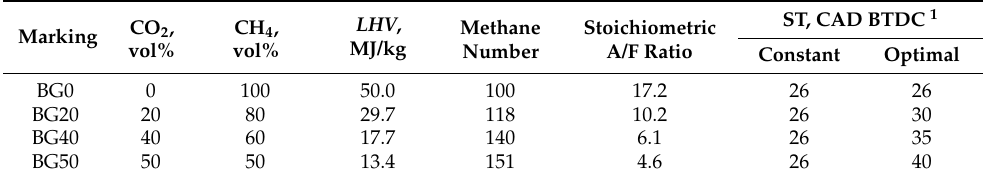
Table 4. Biogas properties and ST